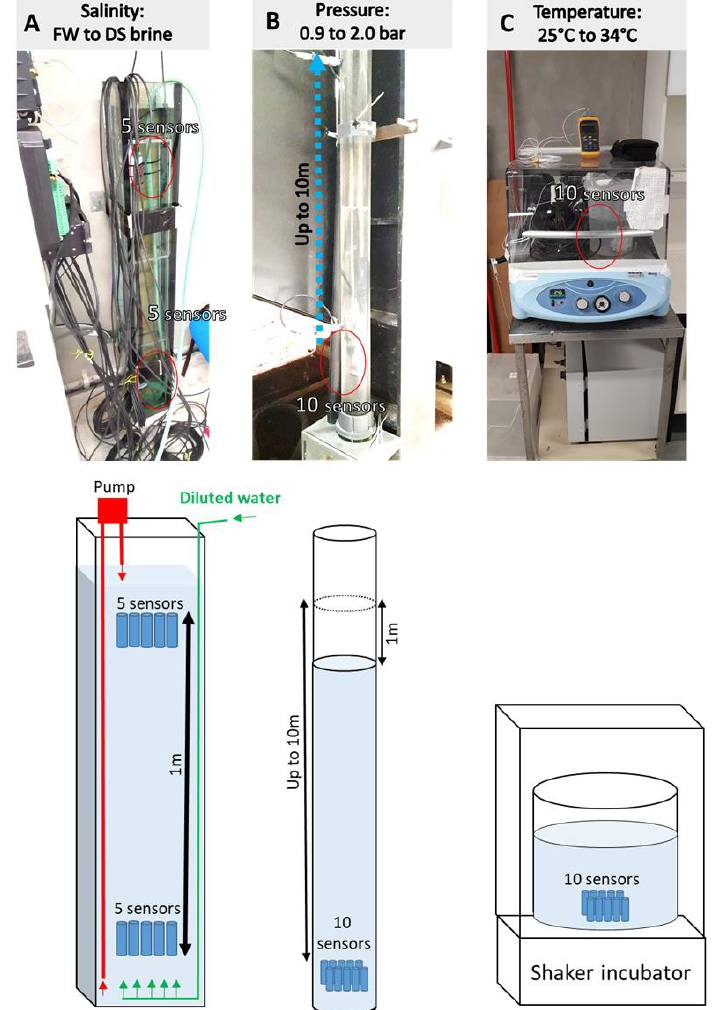
Figure 3. Laboratory experiment design. ( A ) Verification of the hydrostatic densitometer in water density ranging from freshwater (FW) to hypersaline brine (DS brine). The sensors were placed on a steel cage inside a water tank, in two groups of five with 1 m vertical separation. ( B ) Sensitivity of the hydrostatic densitometer to variations in pressure. The 10 sensors were placed at the bottom of a 10 m long column filled with freshwater. ( C ) Sensitivity of the hydrostatic densitometer to variations in temperature. The 10 sensors were placed in a pail of water inside a shaker incubator.